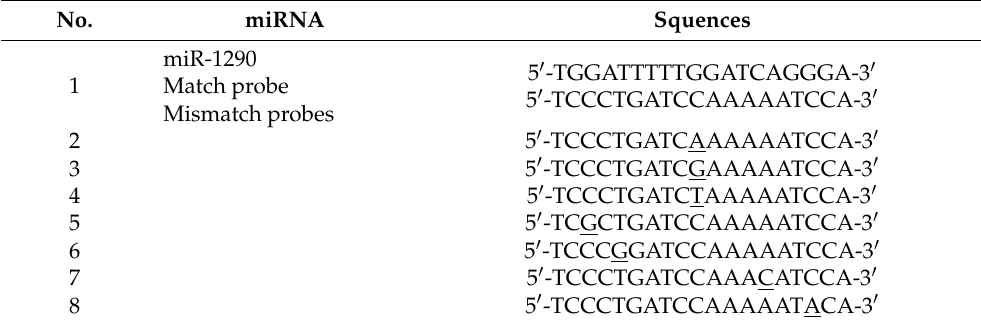
Table 3. Matching and mismatching sequences for pancreatic cancer